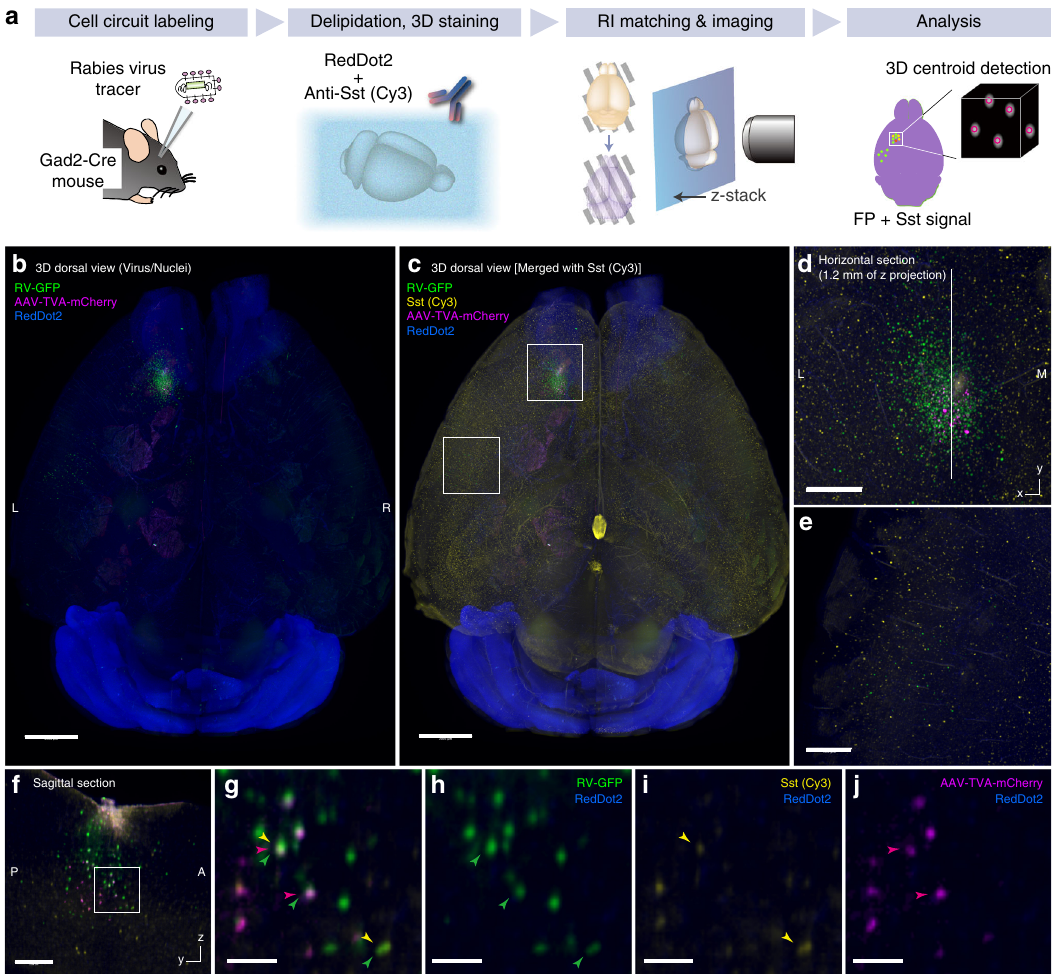
Fig. 7 CUBIC-HV allows whole-organ cellular circuit analysis. a Experimental schematic of whole-brain rabies virus (RV) tracing with cell-type immunolabeling. b Whole-brain image of the RV-injected Gad2-Cre adult mouse brain reconstituted with Imaris software. TVA-mCherry and RV-GFP were injected into left M1 region of the cerebral cortex. Voxel size 8.3 × 8.3 × 9 μ m 3 . Scale: 2 mm. c Anti-Sst antibody staining channel was merged with the image in b . Scale: 2 mm. d , e Enlarged horizontal section images at the indicated positions in c , showing the RV-labeled neurons in the local and ipsilateral corticocortical circuits. Scale: 0.5 mm. f Reconstituted sagittal ( y – z ) section at the position indicated in d . Scale: 0.5 mm. g - j Cropped and enlarged images at the positions indicated in f . Starter neurons (green and magenta) and input neurons (green) with or without an Sst signal could be identi fi ed with single- cell resolution. Scale: 0.1